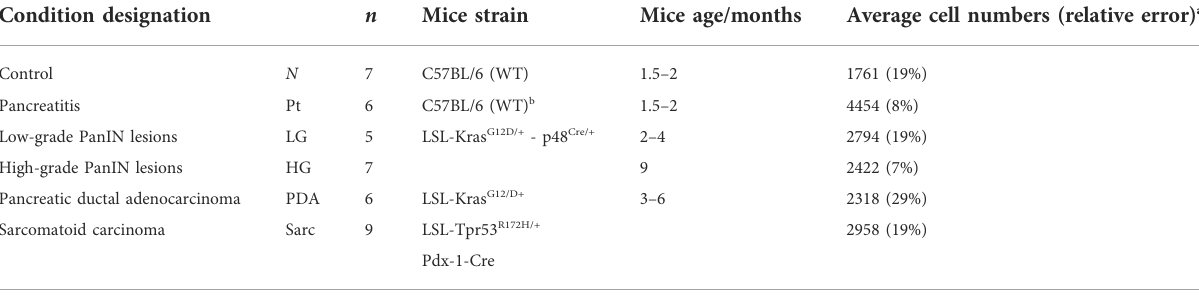
TABLE 1 Characterization of mice groups studied, including corresponding sample numbers (n), strain, age and average number of pancreatic